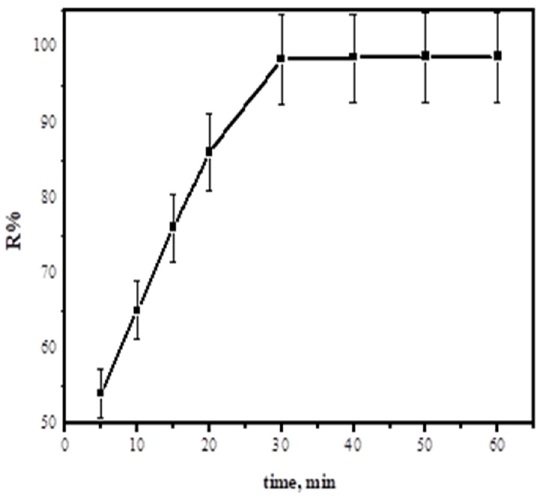
Figure 8. Effect of the contact time of removal efficiency of Pb(II) ions by the GA/MNP composite at 298 K.